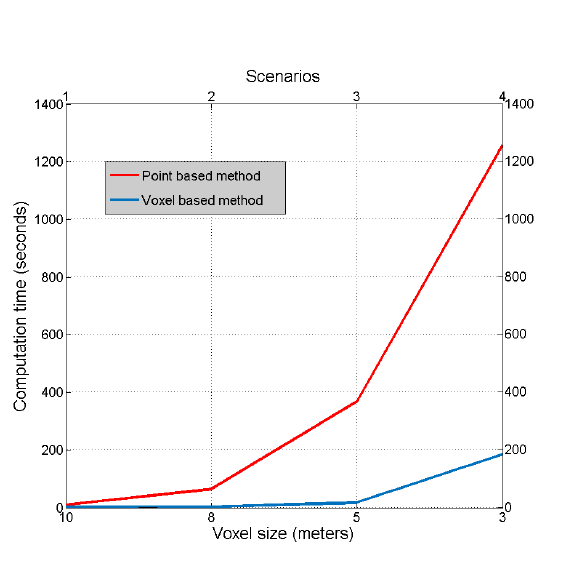
Figure 8: Computation time for different voxel cell sizes and down-sampling